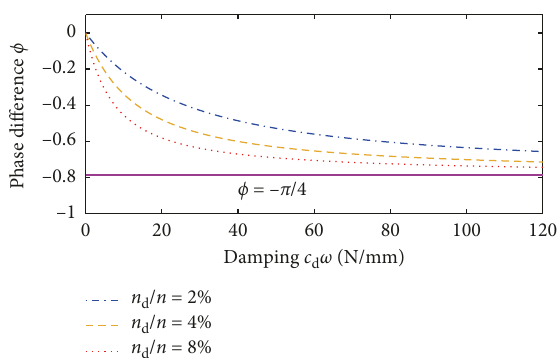
Figure 12: Phase difference at the damper location.